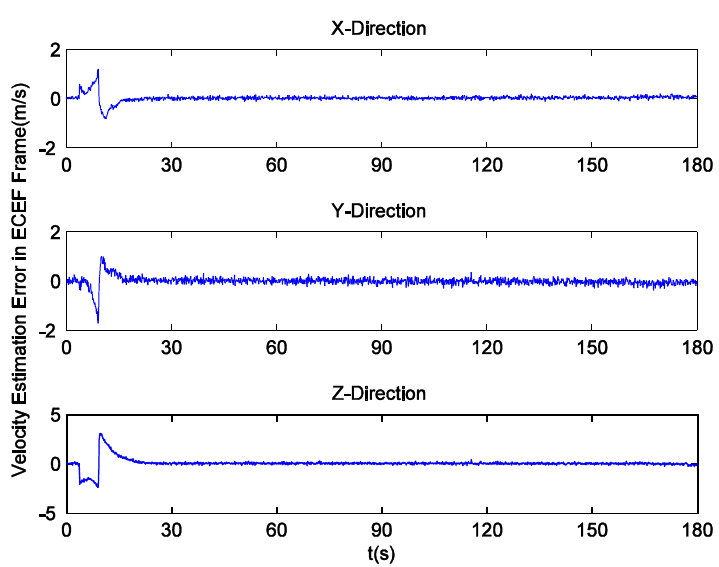
Figure 15. GPS velocity estimation errors with simulation data.